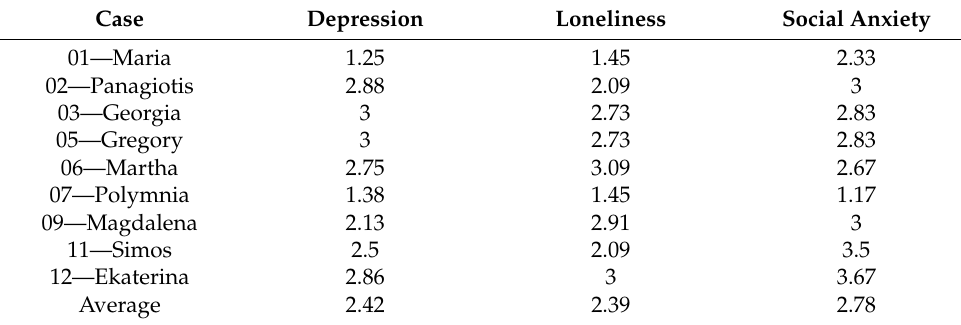
Table 3. Depression, Loneliness, and Social Anxiety. Case